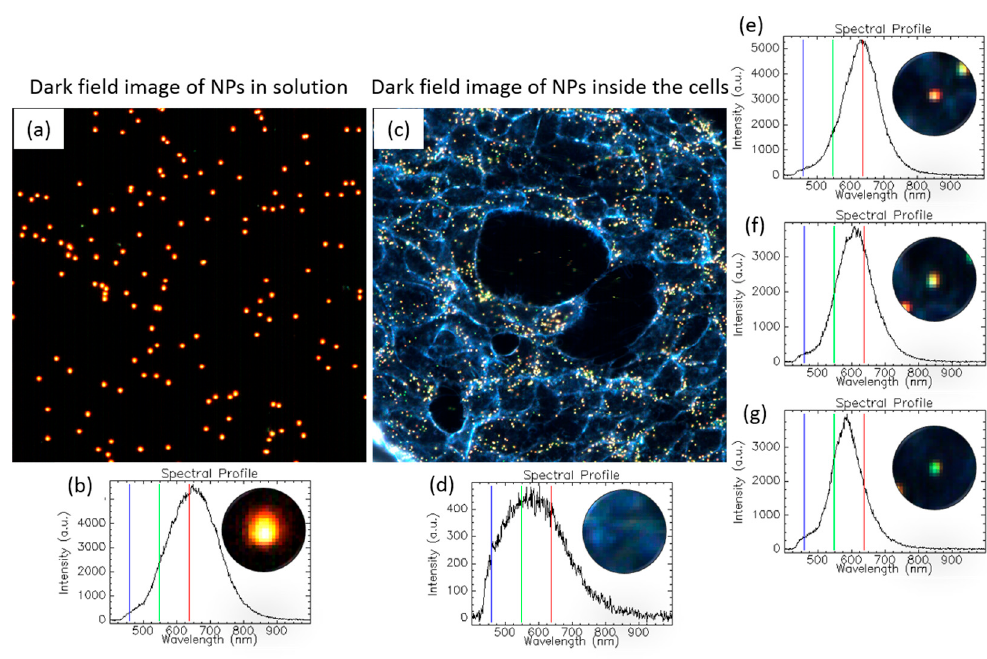
Figure 7. Spectral behavior of Au nanospheres (100 nm) inside and outside a cell. ( a ) Dark field image of the NPs in solution; ( b ) single spectral profile from one particle randomly selected; ( c ) dark field image of cells exposed to the NPs; ( d ) spectral signature of the cytoplasmic membrane; ( e – g ) particles showing different scattering behaviors in the intracellular milieu. All the plots show the RGB bars in which the dark field images are based. The hyperspectral images were acquired with the CytoViva setup and processed with ENVI 4.8 software.